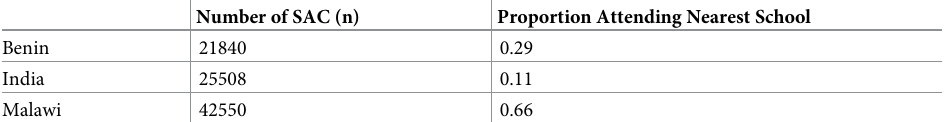
Table 2. Number of School-Age Children in DeWorm3 Catchment Areas and Proportion Attending the School Geographically Nearest to Their Household, by Study